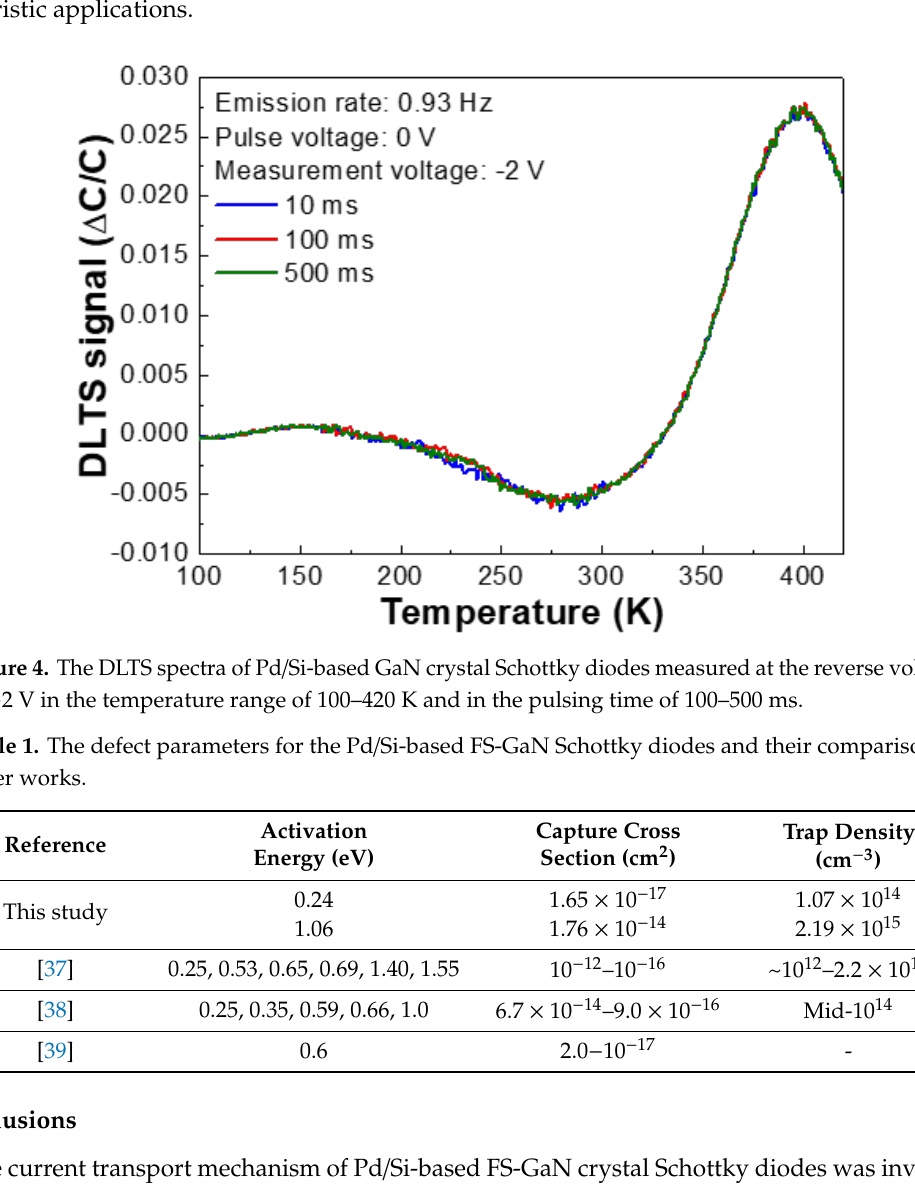
Table 1. The defect parameters for the Pd/Si-based FS-GaN Schottky diodes and their comparison to other works.